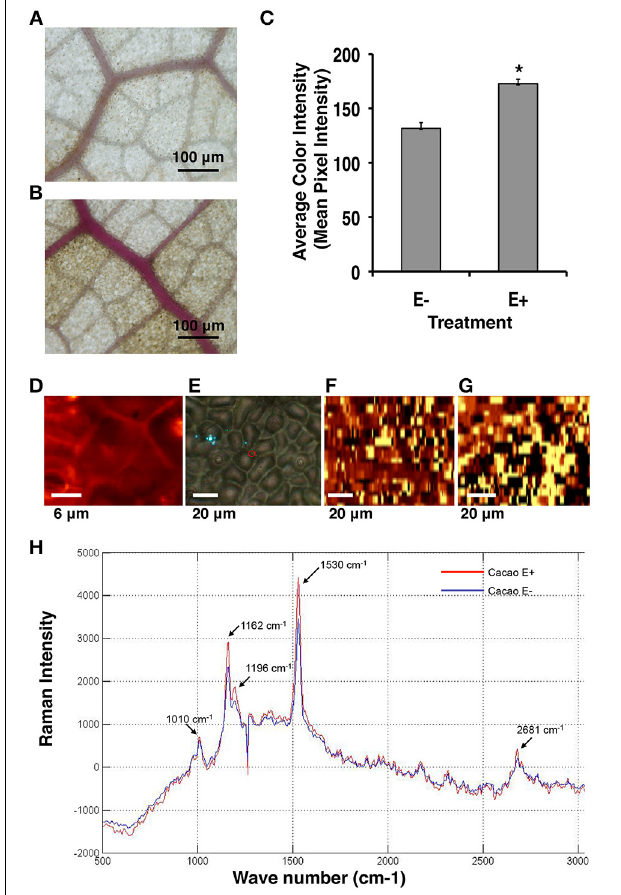
FIGURE 3 | Endophyte inoculated T. cacao leaves (E + ) have higher lignin content than un-inoculated (E − ) leaves. (A) Phloroglucinol-HCL stained E − leaf; (B) Phloroglucinol-HCL stained E + leaf; (C) Comparing color intensity of the E − and E + stained leaves (means ± SE). E + leaves exhibited higher purple staining of the vascular tissue compared to E − leaves indicating ∼ 23% higher lignin accumulation in the E + tissues. ∗ Significance determined at p < 0 . 001. (D–H) Raman imaging and spectrometry reveal higher concentration of lignin and cellulose content in E + epidermal leaf cells relative to E − . (D–G) Representative images of epidermal leaf cells: Bright yellow areas indicate high concentration of lignin and dark black regions indicate very low concentration of lignin; (D) Two-dimensional Raman image (false color) of lignin spatial distribution in the epidermal cells at 100 × ; (E) Bright field (white light) image of epidermal leaf cells at 40 × ; (F) Two-dimensional image of lignin spatial distribution in E − leaf cells at 40 × ; (G) Two-dimensional image of lignin spatial distribution in E + leaf cells at 40 × ; (H) Spectral bands of lignin (1530cm − 1 ) and cellulose (1162cm − 1 ) (see Section Materials and Methods). These results were very similar to results from the Phloroglucinol-HCL staining